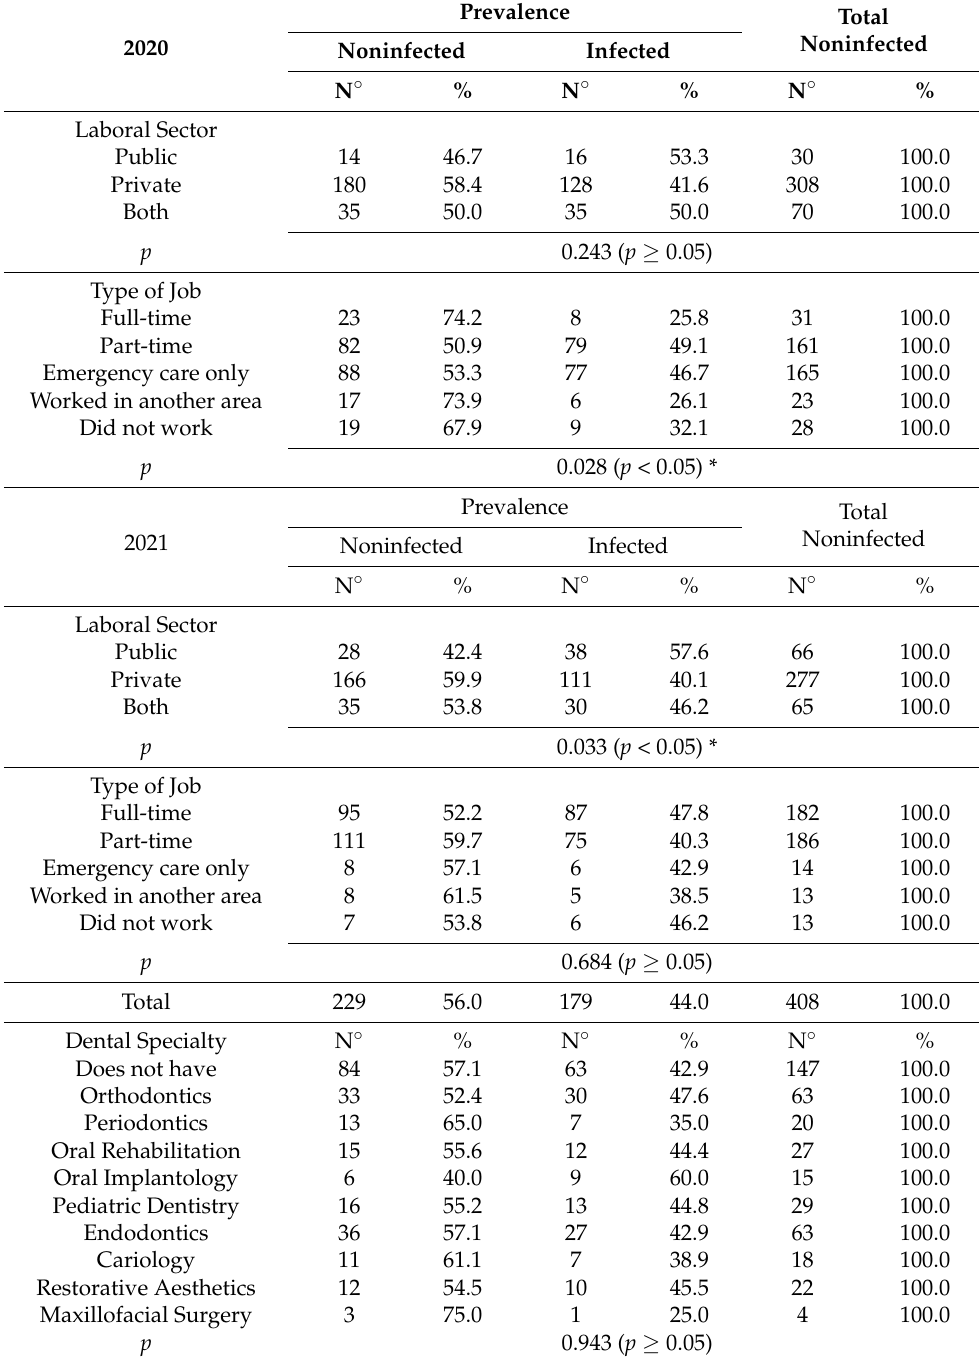
Table 2. Employment characteristics of dentists in 2020 and